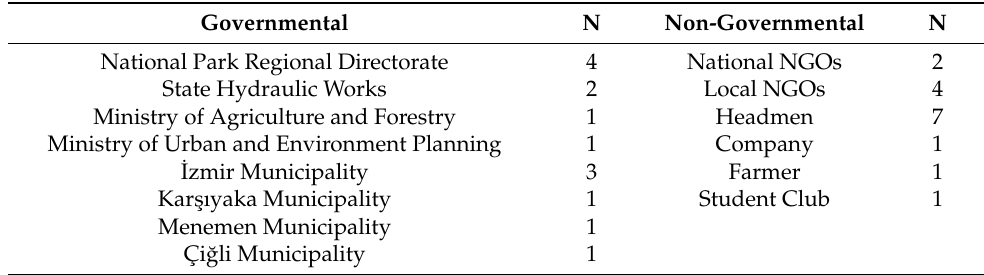
Table 1. List of stakeholders in the Gediz Delta participating in the semi-structure interviews about environmental threats in the